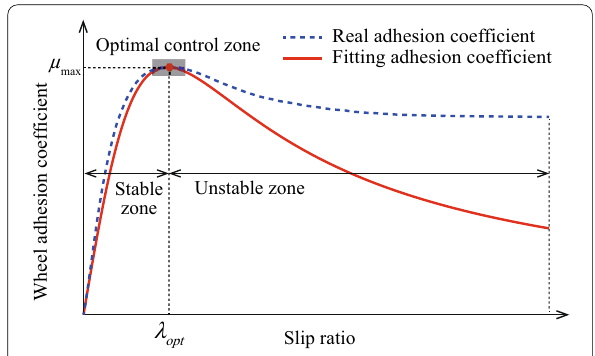
Figure 2 Relationship between adhesion coefficient and slip